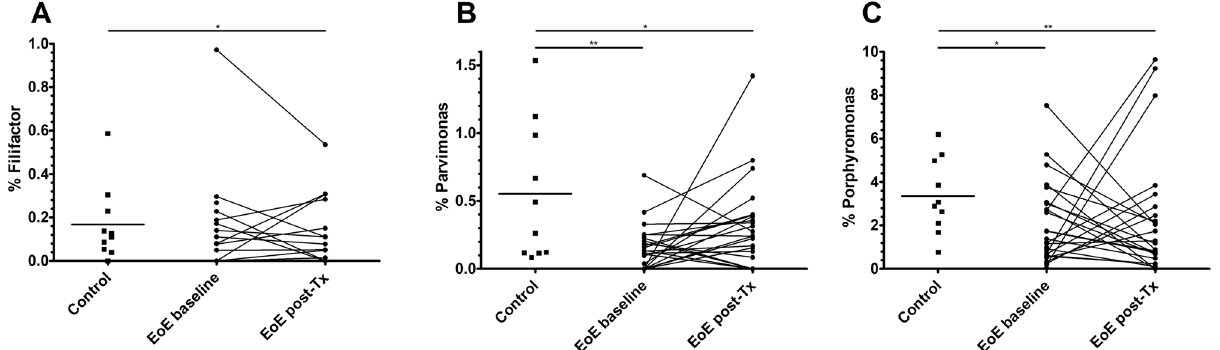
Figure 5. Dot plot representation for each condition of the relative abundance in oesophageal biopsies of bacterial genera Filifactor ( A ), Parvimonas ( B ) and Porphyromonas ( C ). EoE: eosinophilic oesophagitis; EoE post-Tx: EoE patients after treatment. * p < 0.05; ** p < 0.01 (adjusted p -values). BH-adjusted p -values